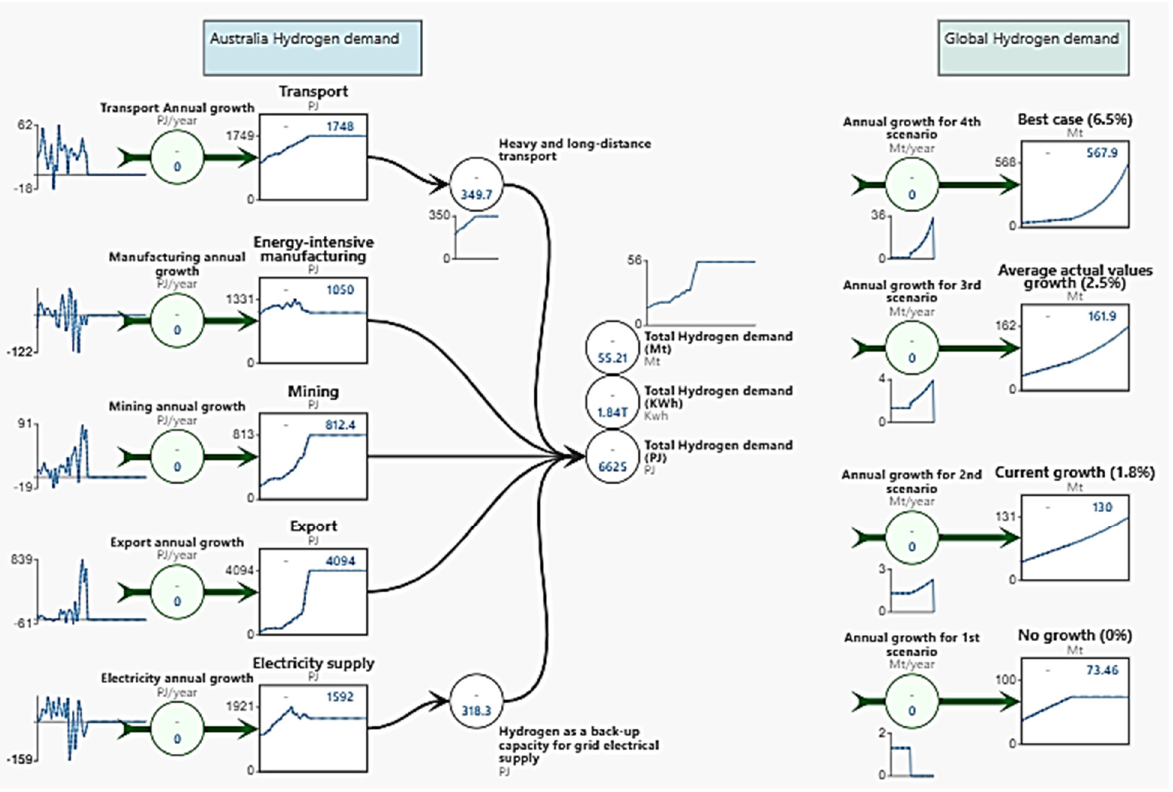
Figure 8. The system dynamics model of hydrogen demand.